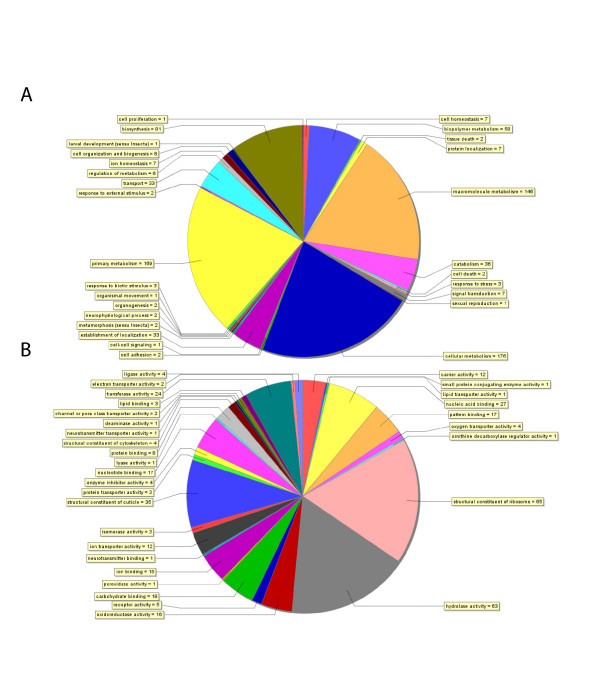
The distribution of gene annotations for the list of 787 Daphnia pulex ESTs based on results from Blastx searches against the NCBI non-redundant protein database. (A) The assignment of 799 annotations of biological process to 227 EST clusters from level 4 of the Gene Ontology. (B) The assignment of 371 annotations of molecular function to 288 EST clusters from level 3 of the Gene Ontology. Blastx queries recorded the best 5 matches with an E-value threshold of 1 × 10-3 and a minimal value of 33 aligned amino acids. Gene Ontology (GO) terms were assigned to ESTs using Blast2GO [22] with the following configurations: Pre-eValue-hit filter 1 × 10-3; Pre-similarity-hit filter 2; Annotation cut-off 35; GO weight 5.